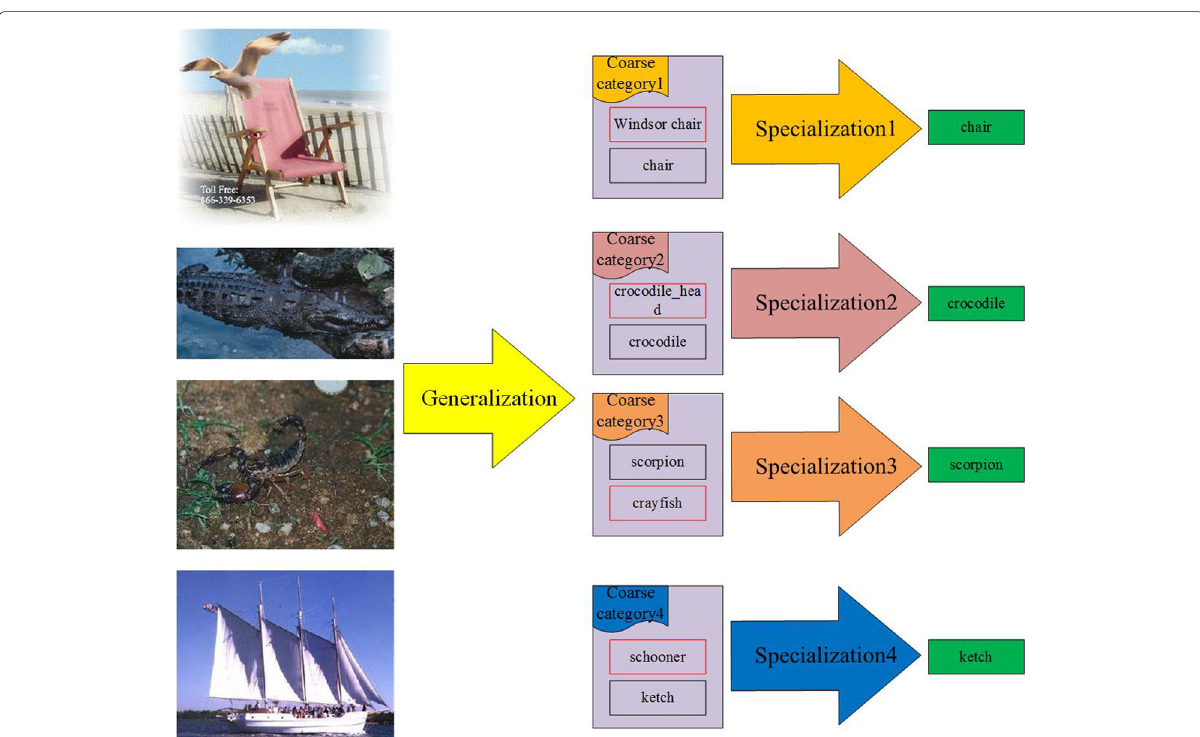
Fig. 6 Some images from Caltech101 were misclassified by the Trunk-CNN and corrected by Branch-CNNs. The red box in Coarse categories represents the output of the fine category by the Trunk-CNN. The green box represents the final output of the